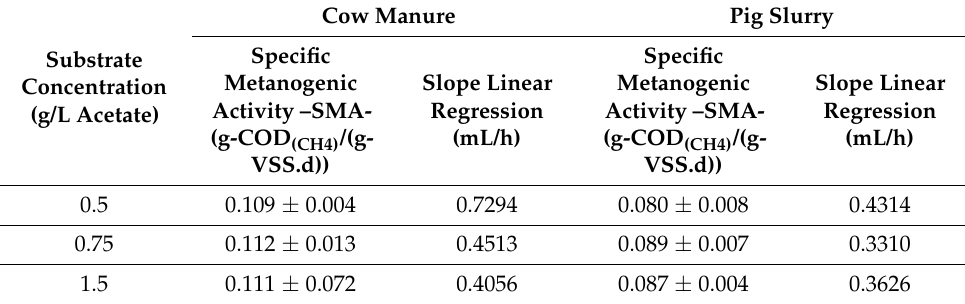
Table 3. Values of specific methanogenic activity